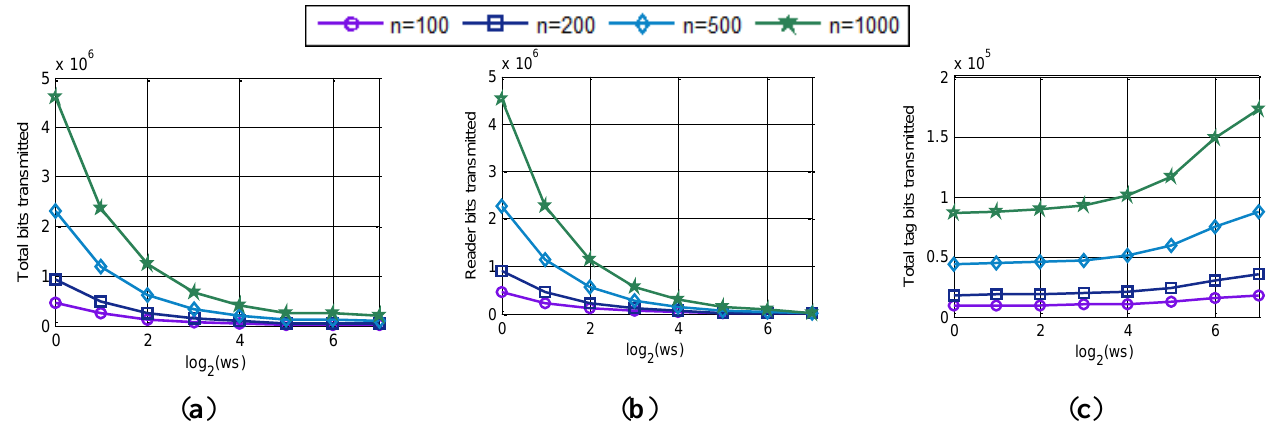
Figure 12. Simulated results of: ( a ) total bits transmitted; ( b ) reader bits transmitted and ( c ) total tag bits